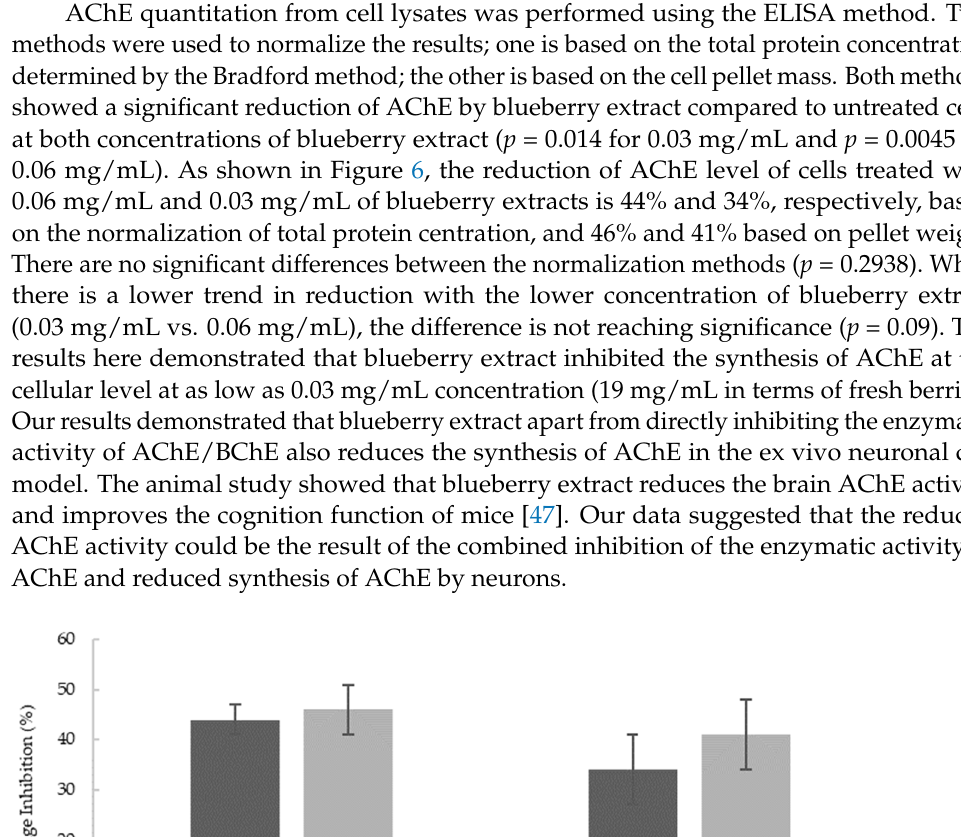
Figure 5. Cell morphology post 18 h of treatment at various concentrations of blueberry extract (magnification 10× and resolution 12).